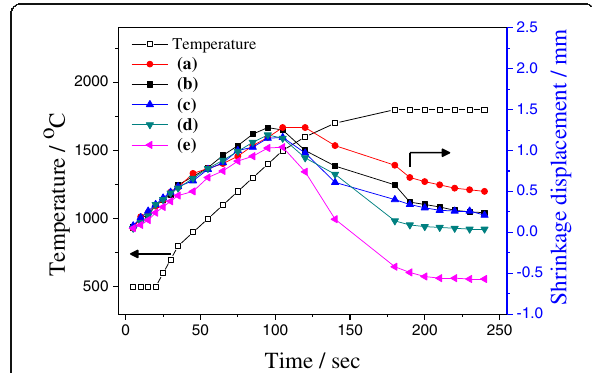
Fig. 8 Shrinkage displacement change of SiC pellets sintered with